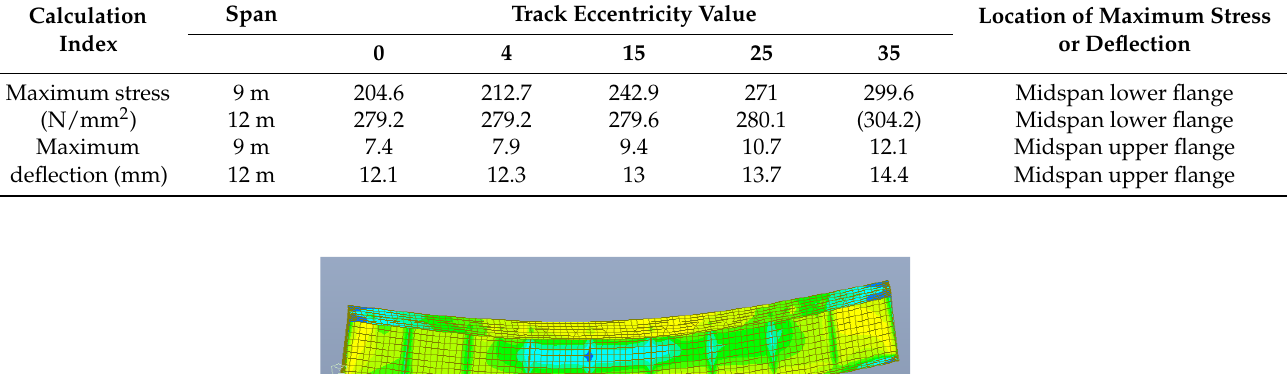
Table 5. Finite element calculation results of crane beam.